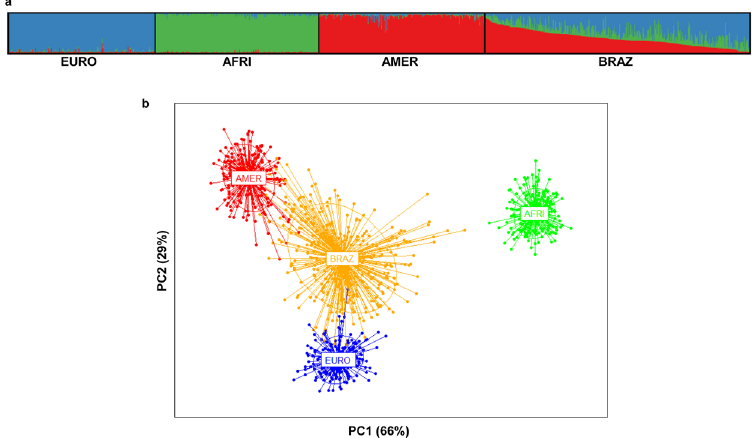
Figure 1. Genomic ancestry of the Rio Pardo population. ( a ) Genomic individual ancestry bar plot, including worldwide populations and the Rio Pardo population. Each individual is represented by a thin vertical line that is partitioned into three colored segments corresponding to the individual’s estimated membership proportion in the European (blue), African (green) and Native American (red) clusters. ( b ) PCA representation of individual ancestry. EURO, European; AMER, Native American; AFRI, African and BRAZ, Brazilian (Rio Pardo